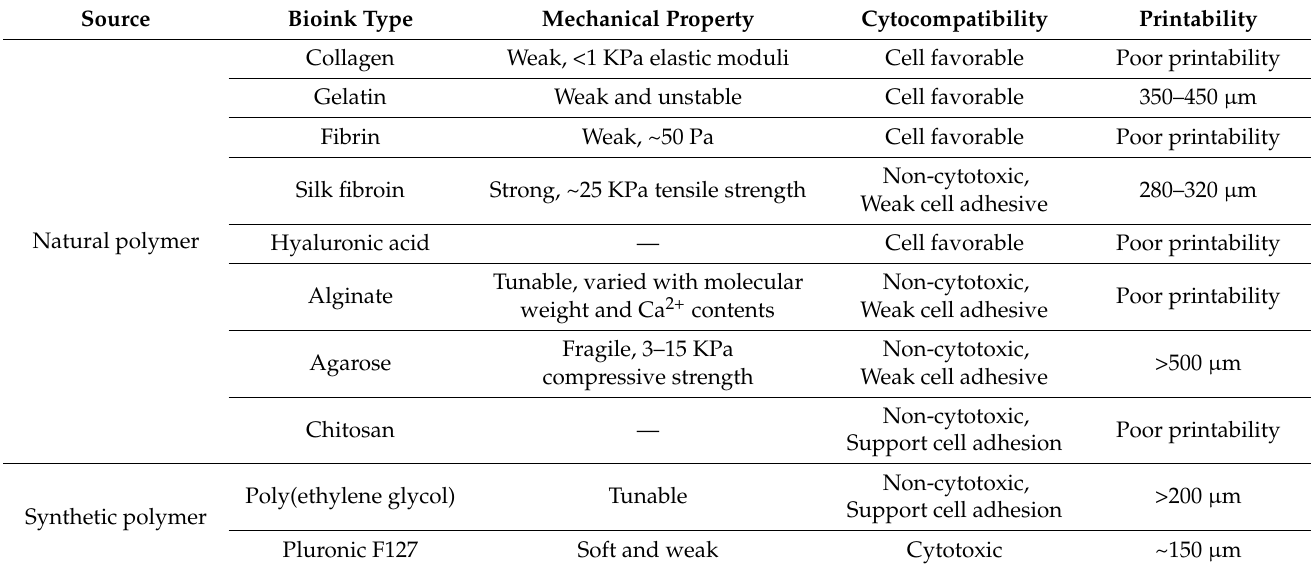
Table 2. Comparison of properties of bioinks for 3D bioprinting